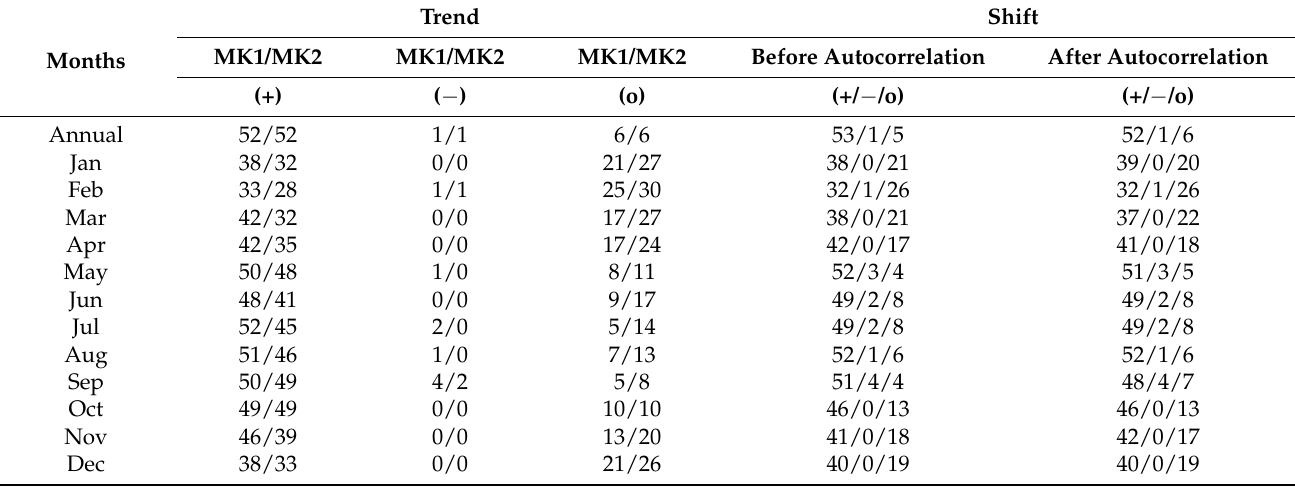
Table 1. Summary of stations showing statistically significant monthly sea level trends at a 95% confidence level for tide gauges using MK1/MK2 test before/after autocorrelation and